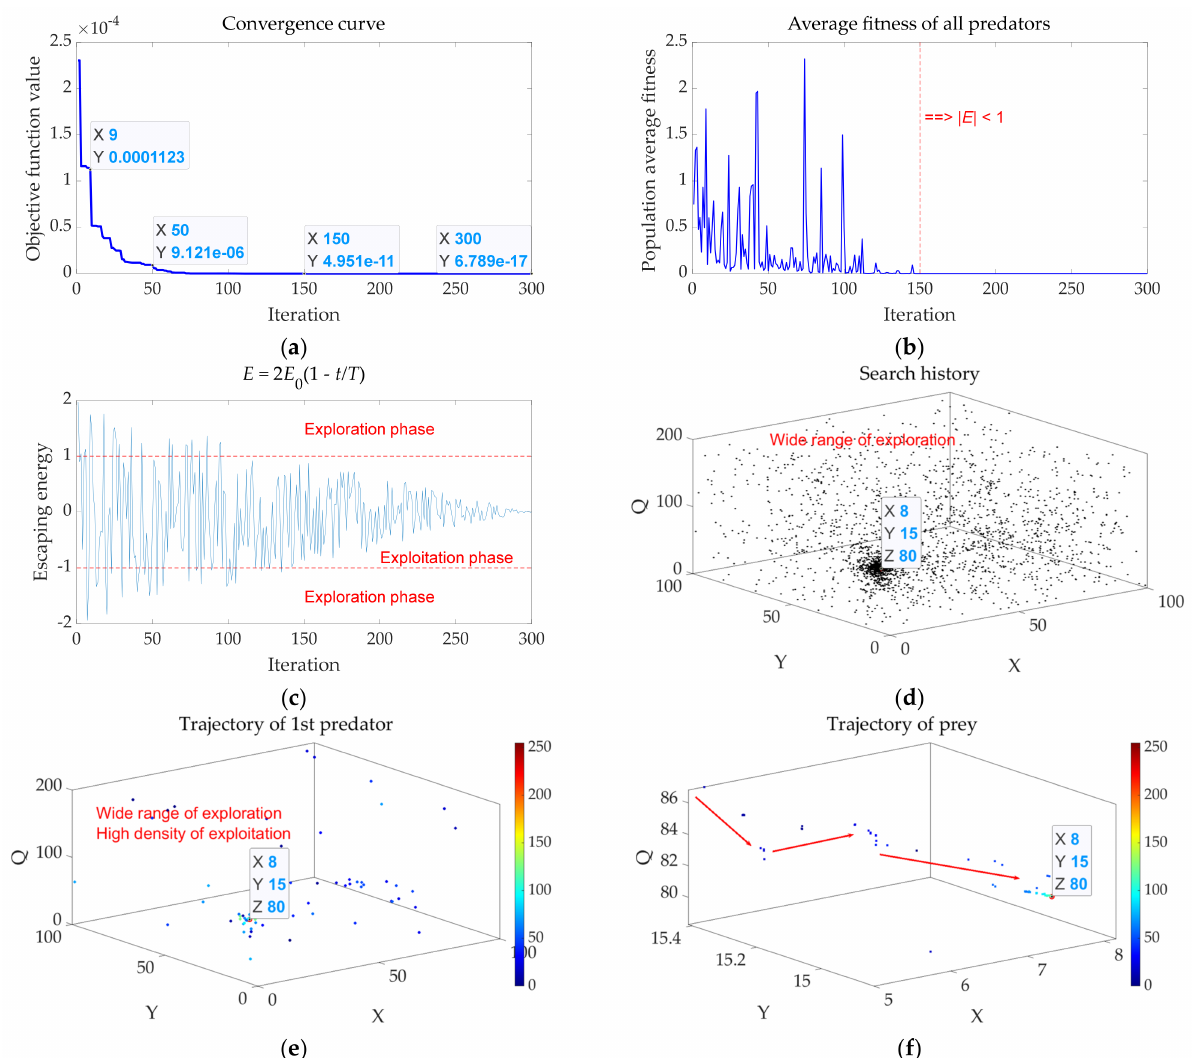
Figure 6. Qualitative results figures of OMO algorithm under 16 sensors. ( a ) Convergence curve; ( b ) average fitness of all predators; ( c ) escape energy of the prey; ( d ) search history of predators; ( e ) trajectory of the first predator; ( f ) trajectory of the